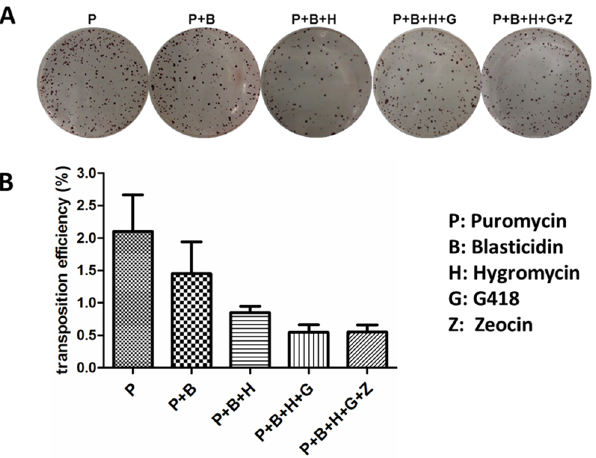
Fig. 7. Transposition efficiency of multiplex gene transfer based on PiggyBac system in mouse ESCs. (A) AP staining for transfected stable ES cell clones using different combinations of antibiotics selections. Each dot represents a stable ES cell clone. (B) Transposition efficiency of PiggyBac mediated multiplex gene transfer. Data was based on two independent experiments.